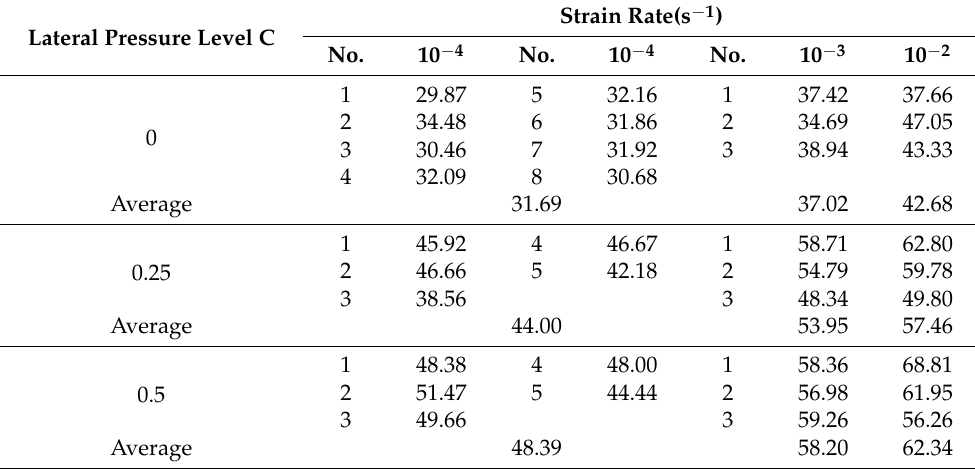
Table 5. Peak stress (MPa) at different lateral pressures and different strain rates.